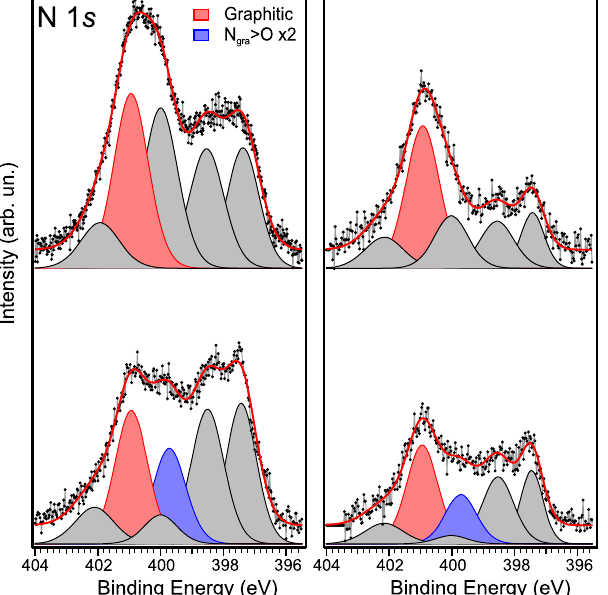
Figure 4. N 1 s core level spectra for the two N-graphene samples annealed to 300 (left) and 600 °C (right) before (top) and after (bottom) the exposure to molecular oxygen. Highlighted in colours are the graphitic components with (blue) and without (red) oxygen atoms bonded in epoxy configuration with the nearest carbon